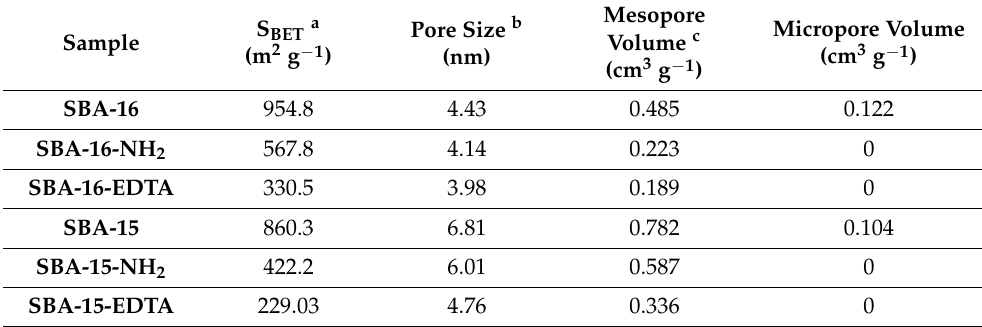
Table 1. Textural properties of SBA-16 and SBA-15 before and after